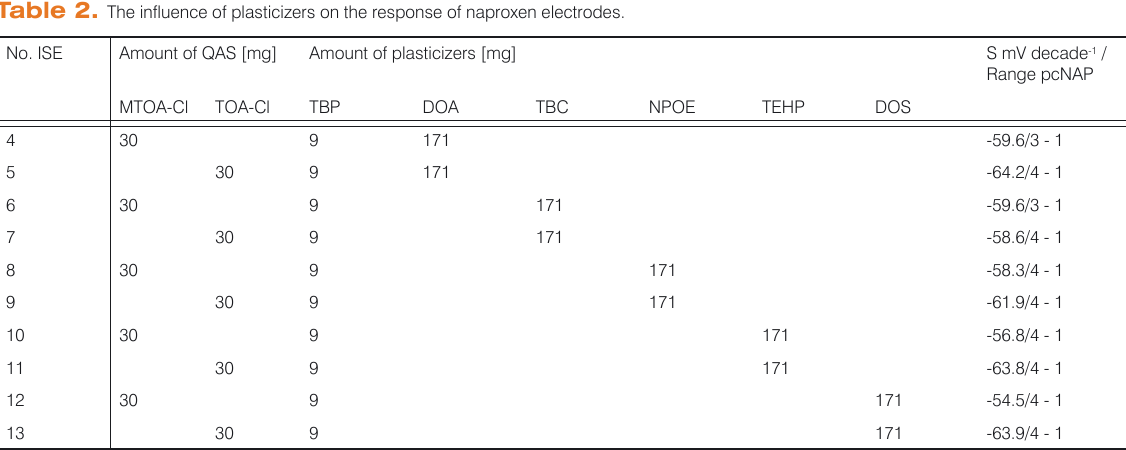
Table 2. The influence of plasticizers on the response of naproxen